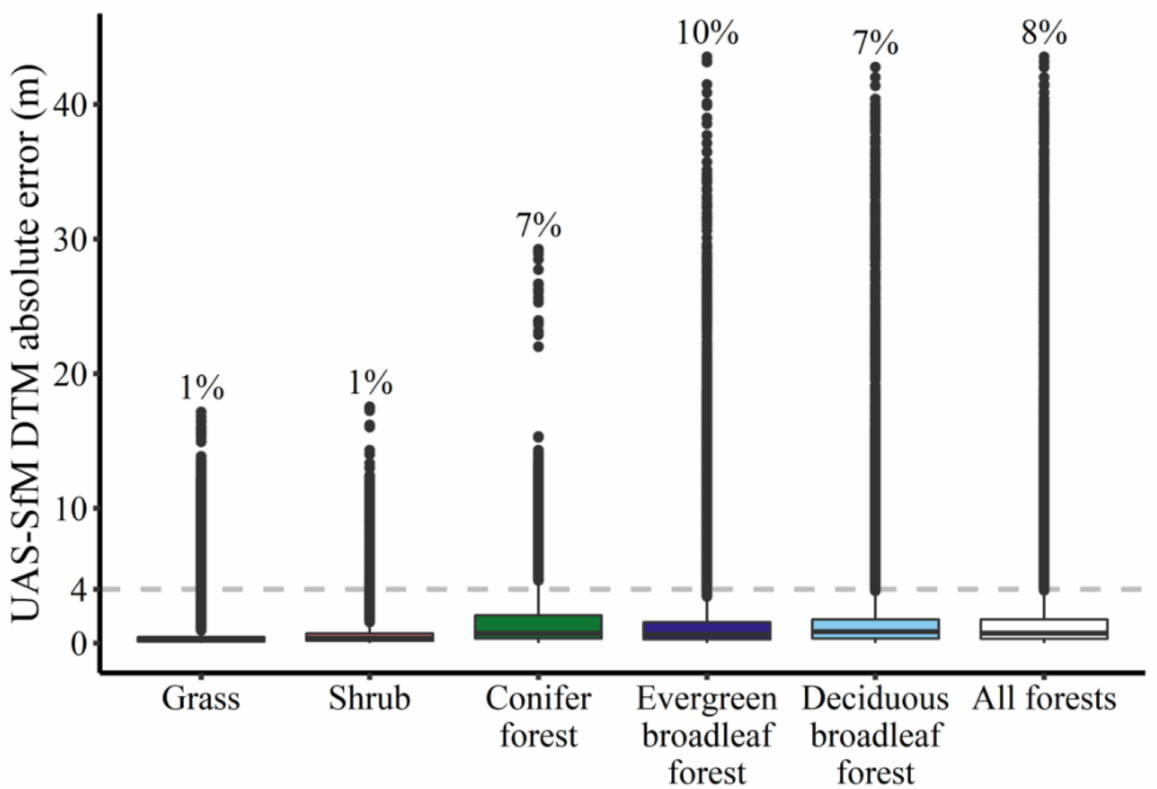
Figure 4. Boxplot of UAS-SfM DTM 1-m cell error by vegetation type for DTM obtained from optimized CSF parameters as compared to the ALS DTM. Numbers above each boxplot represent percentage of DTM cells with greater than 4 m of